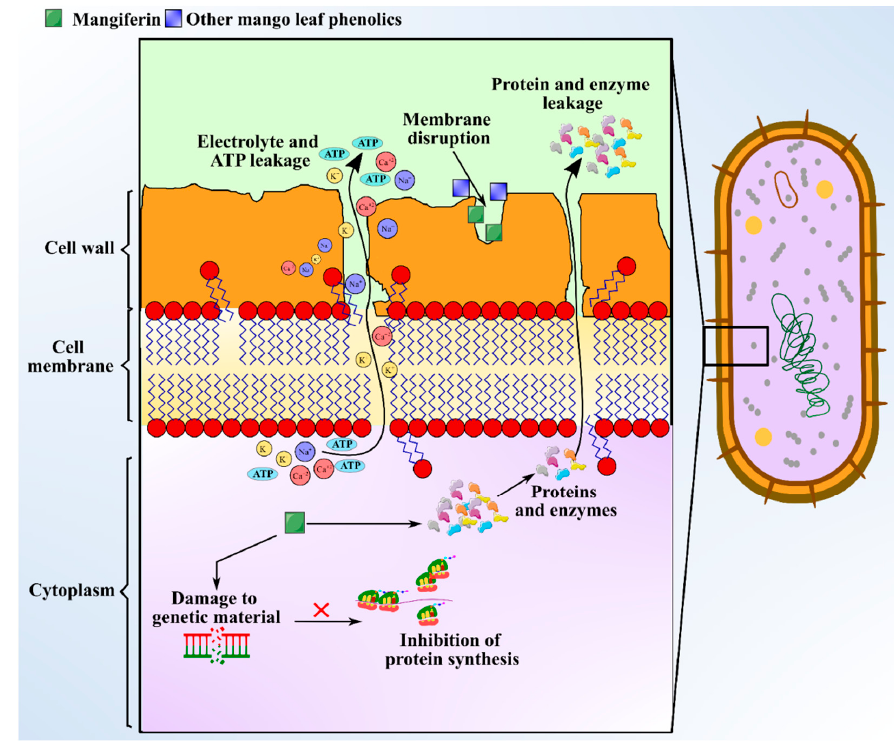
Figure 4. Schematic showing anti-microbial activity of the mangiferin from mango